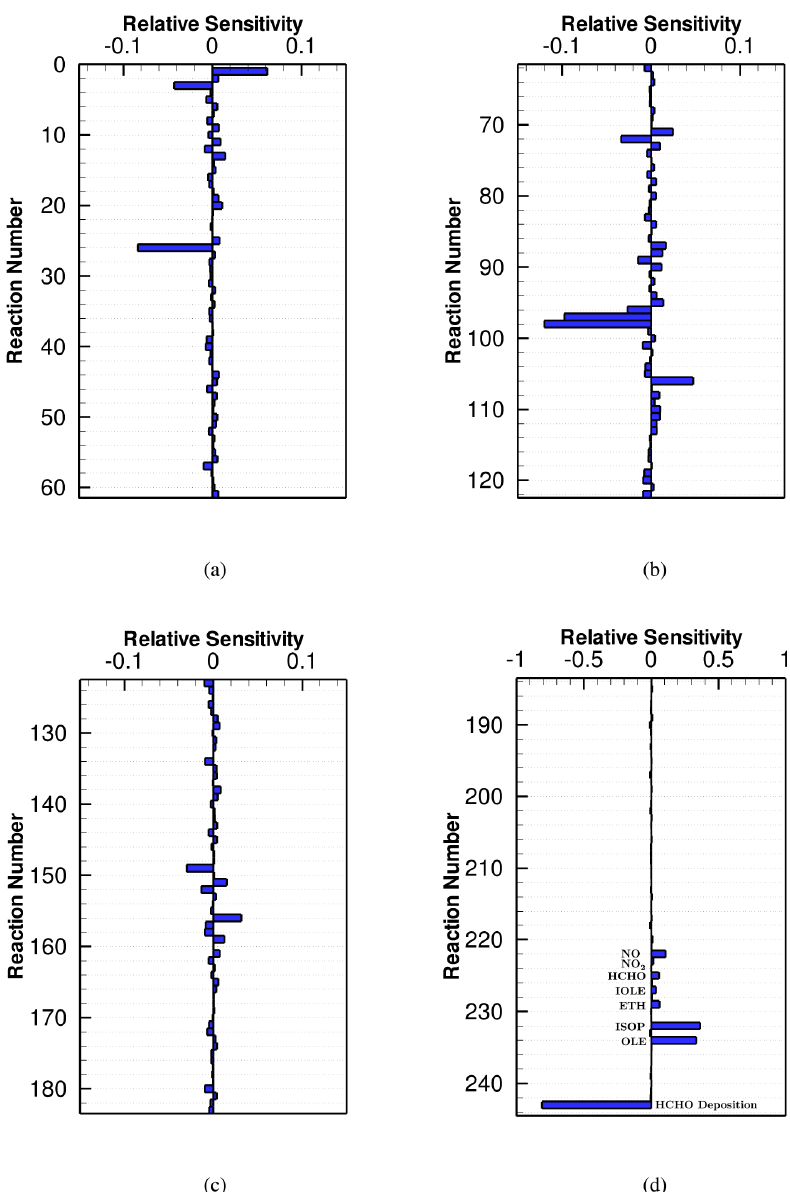
Figure 8. Averaged HCHO sensitivity to the CB6r3 mechanism over the seventh day, when the surface emission is strong. All the values of the sensitivities shown in this figure can be found in Table